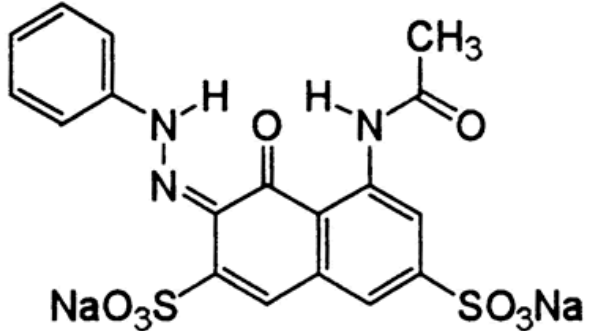
Figure 12. The molecular structure provided by PubChem for AR1.